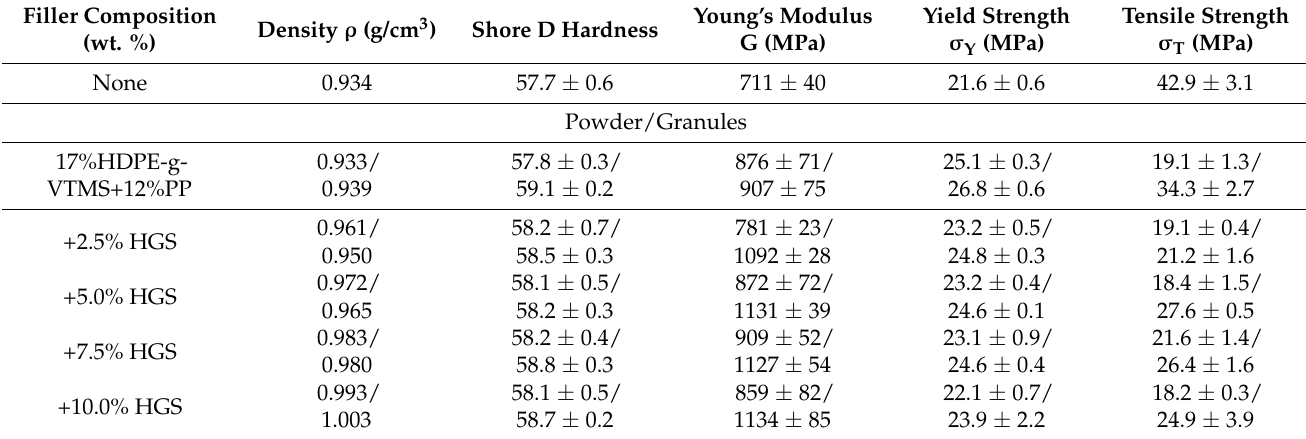
Table 2. The mechanical properties of neat UHMWPE and the ‘UHMWPE+17%HDPE-g-VTMS+12%PP’-based composites loaded with hollow glass spheres